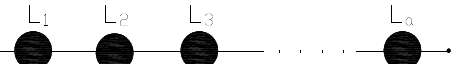
Figure 1. Line of transmission with a series-connected component.